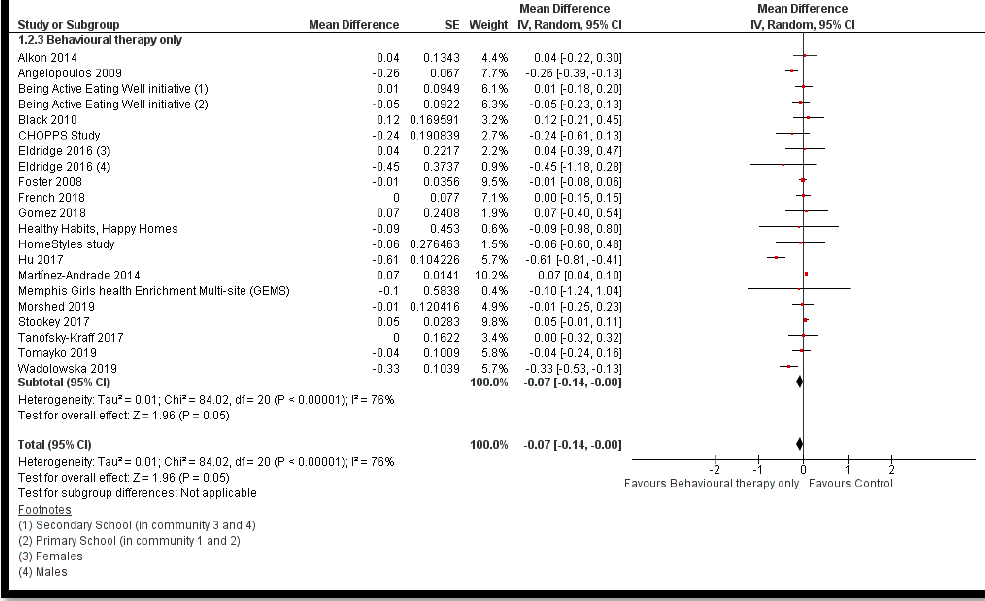
Figure 7. Forest plot for the effect of combined diet, exercise and behavioral therapy interventions for obesity prevention on body mass index (BMI) z -score .